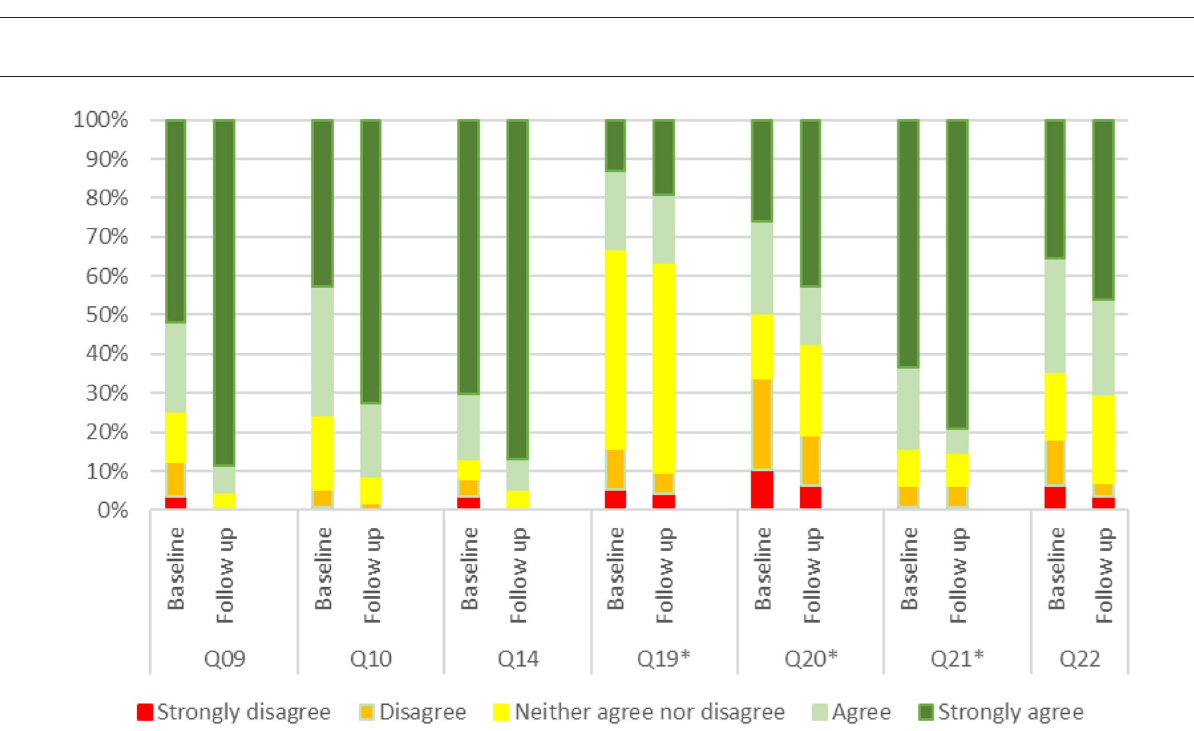
FIGURE2 Most significant change in items’ response between baseline and follow-up. *Are negative statements so answers were